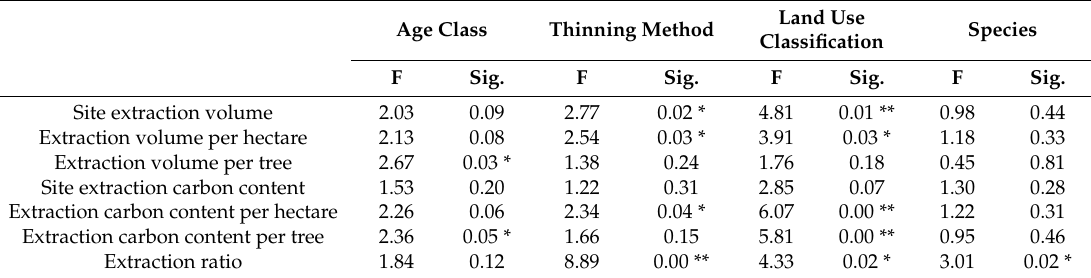
Table 7. ANOVA for the site/species attributes and carbon content for extracted wood.